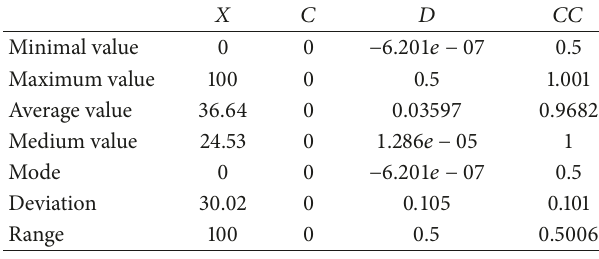
Table 7: The statistical analyses of strategies 𝐶 , 𝐷 , and 𝐶𝐶 .